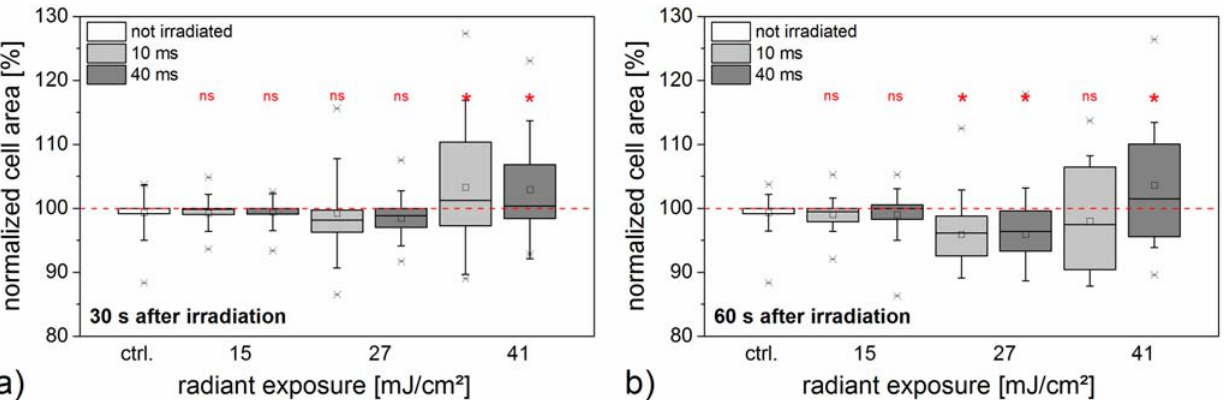
Fig 4. Cell area evaluated by holographic microscopy after laser manipulation. Cell area a) 30 s and b) 60 s post irradiation is normalized to the cell area before laser manipulation. Box plots indicate the distribution of the area for the irradiation times and radiant exposures under examination. The unirradiated control is based on the same dataset in both diagrams. The highest radiant exposure of 41 mJ/cm 2 led to a diversified area distribution, while 27 mJ/cm 2 mainly caused an area decrease. In the case of 15 mJ/cm 2 the area distribution was similar to irradiated cells. Data of at least 22 irradiated cells is